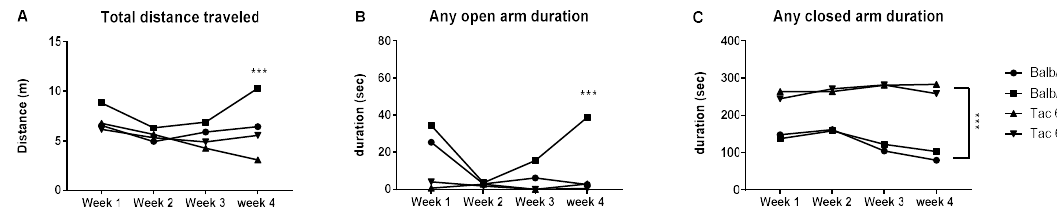
Figure 8. Alteration of anxiety levels by modulation of microbiota through an antibiotic cocktail. Balb/c Cont and Tac 6J Cont mice received 200 µL of distilled water, while 200 µL of an antibiotic cocktail was administered to Balb/c Anti and Tac 6J Anti mice twice a day for four weeks. Each group comprised 5–7 animals. ( A ) The total distance traveled on the elevated plus maze per week; ( B ) Time spent on any of the open arms; ( C ) Time spent on any of the closed arms. The data in Figure 8A,B are presented as the means and were analyzed by Fisher’s LSD test compared to the Balb/c Anti group. The data in Figure 8C represents the means and were analyzed by Fisher’s LSD test compared to the Balb/c and the Tac 6J group. Significance is indicated when * p < 0.05, ** p < 0.01, and *** p <